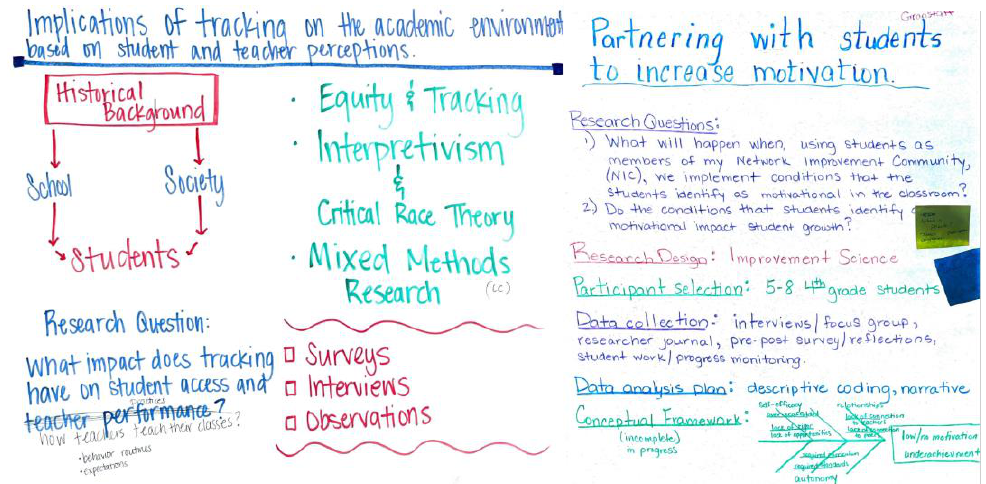
Figure 2. Sample Candidate